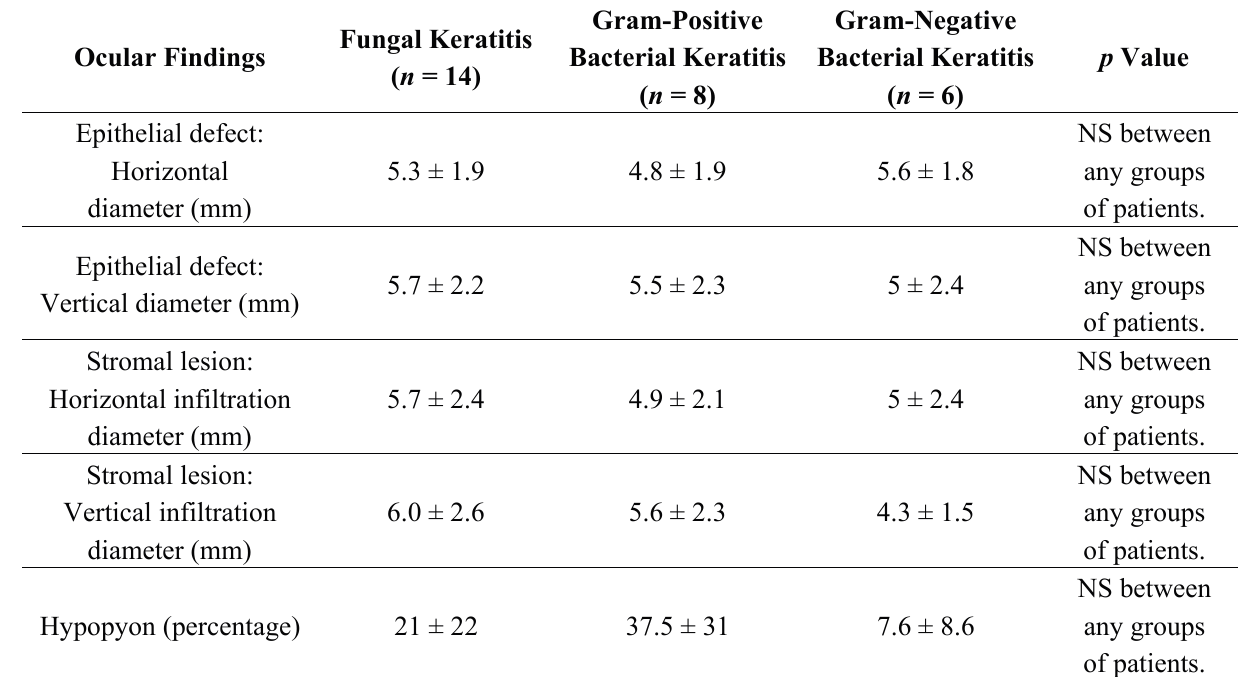
Table 2. Ocular findings in patients with microbial